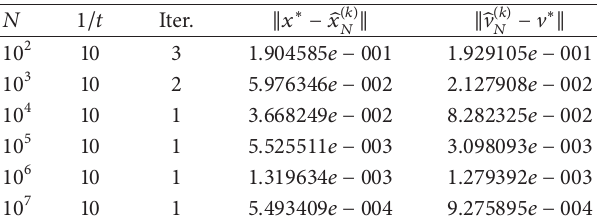
Table 1: The numerical results for Example